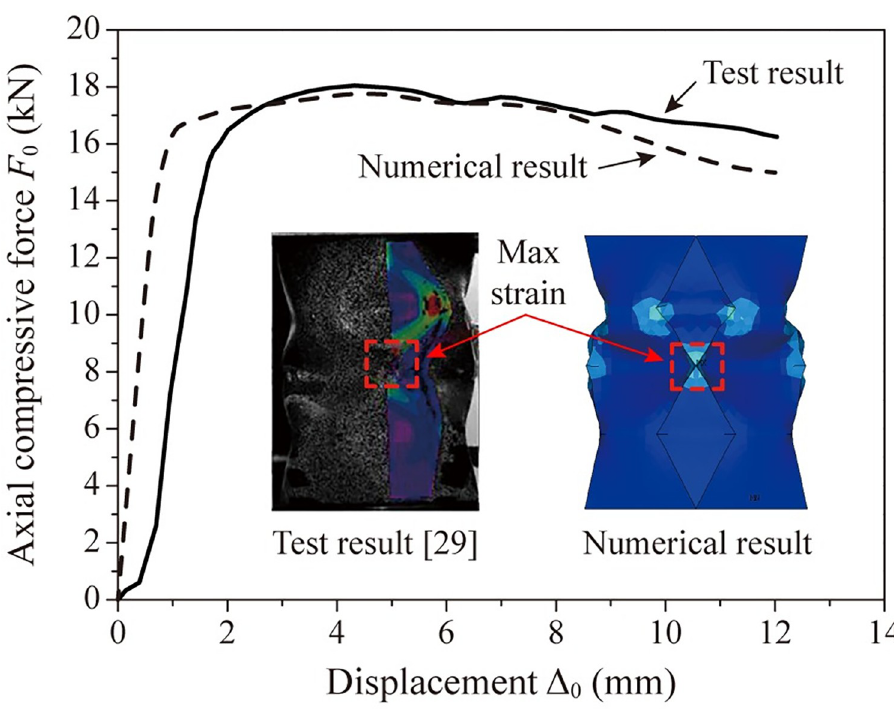
Fig 6. Comparison between test results and numerical results.